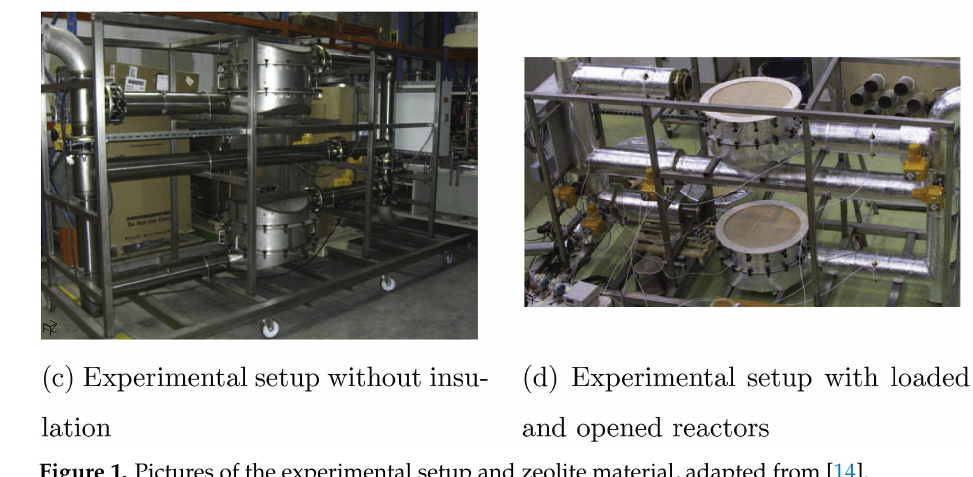
Figure 1. Pictures of the experimental setup and zeolite material, adapted from